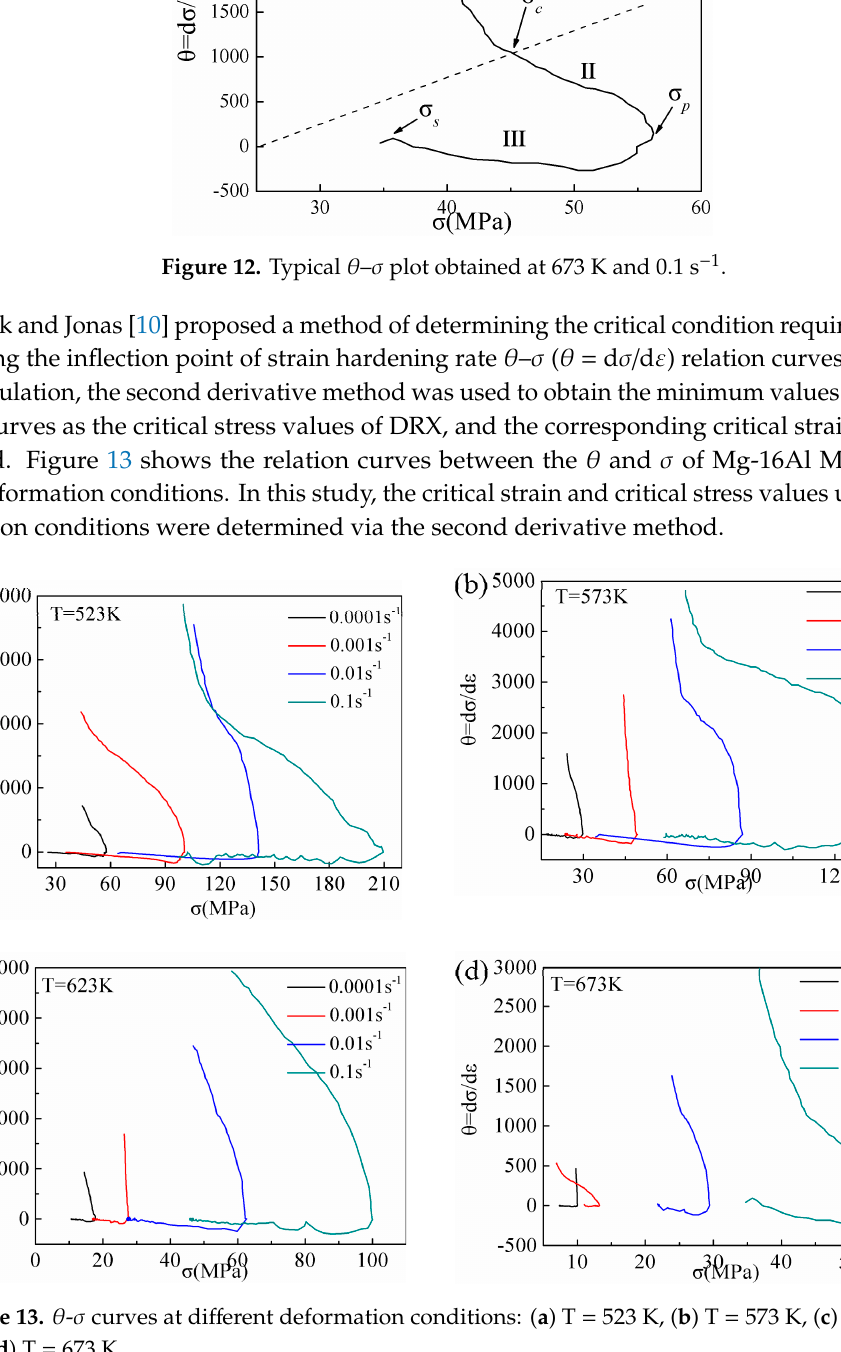
Figure 12. Typical θ – σ plot obtained at 673 K and 0.1 s − 1 .